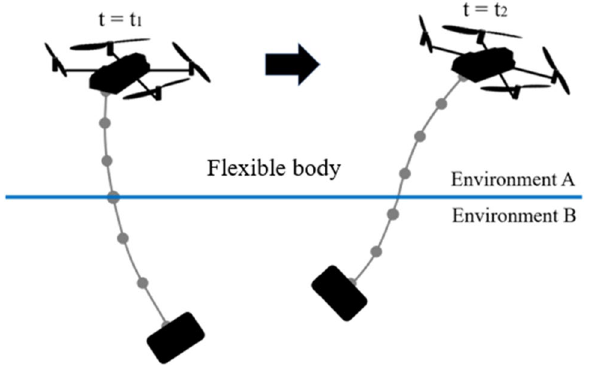
Figure 1. Example of model for conventional methods. Each environment in which each element exists changes as the boundary position changes. In addition, the boundary point of environment A and B is not always at a node.